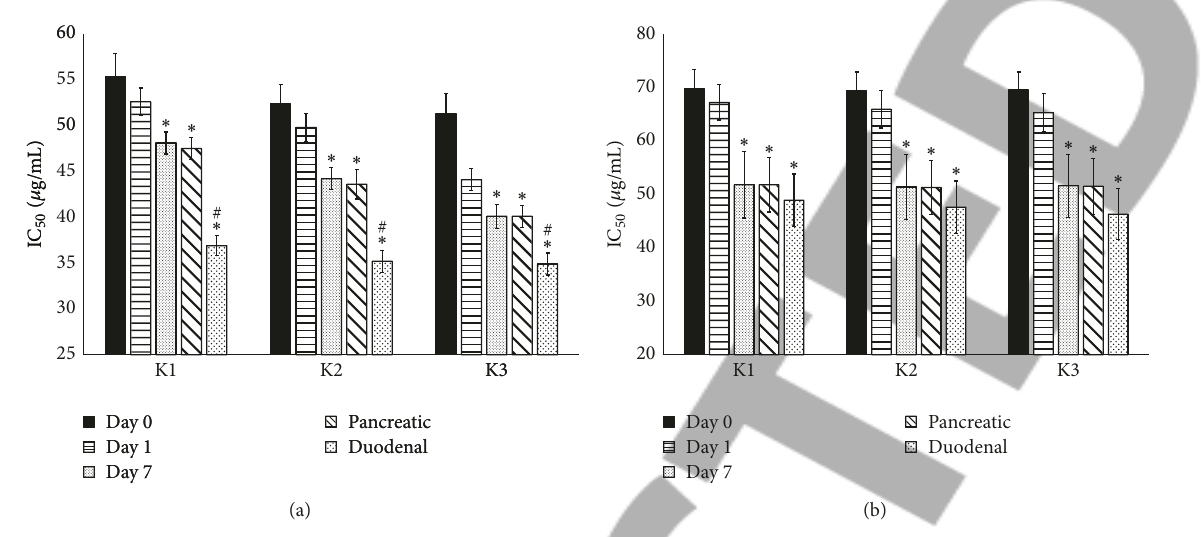
Figure 3: Changes in the (a) 𝛼 -amylase and (b) 𝛼 -glucosidase inhibitory activities of the three Kombucha beverages. Error bars represent the SEM. # 𝑃 < 0.05 versus the value at day 7 (prior to being subjected to the digestion phases).